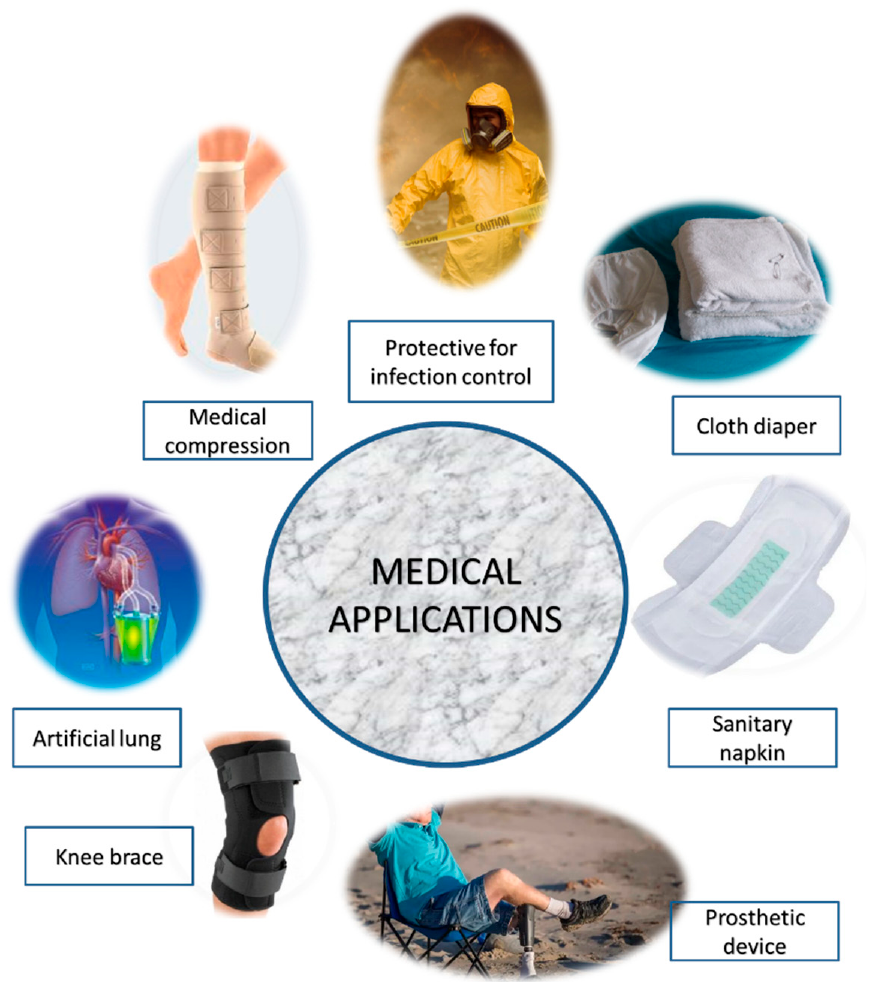
Figure 14. Some examples of textile medical devices. Images were taken from the Internet [82–88].